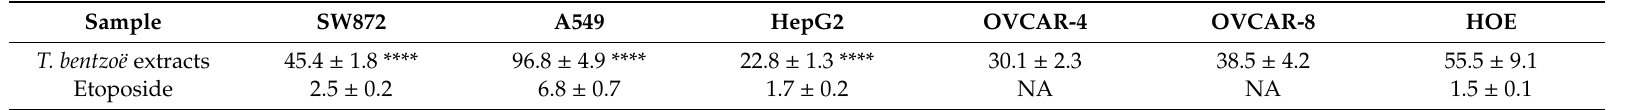
Table 3. Cytotoxicity (IC 50 µ g / mL) of T. bentzoë against human cancer cell